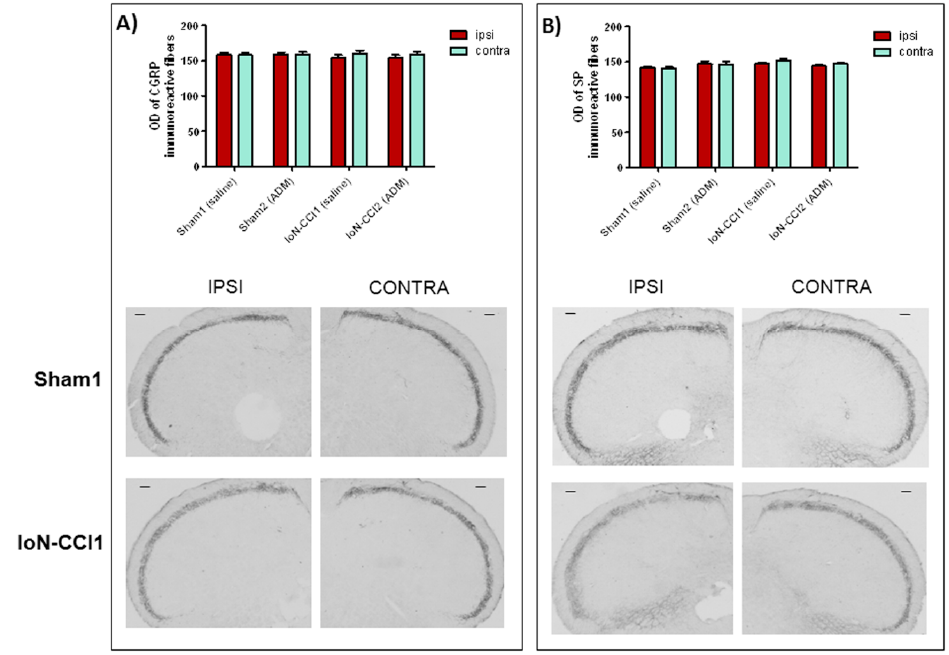
Figure 6. mRNA expression of IL-1beta ( A ), IL-6 ( B ), and TNF-alpha ( C ) in ipsilateral TG and CSC, and in medulla in toto. Data are expressed as mean + SEM. One way analysis of variance (ANOVA) followed by Tukey’s Multiple Comparison Test, *** p < 0.001 vs. Sham1 and Sham2, °°° p < 0.001 vs. IoN-CCI1, # p < 0.05 vs. Sham1.